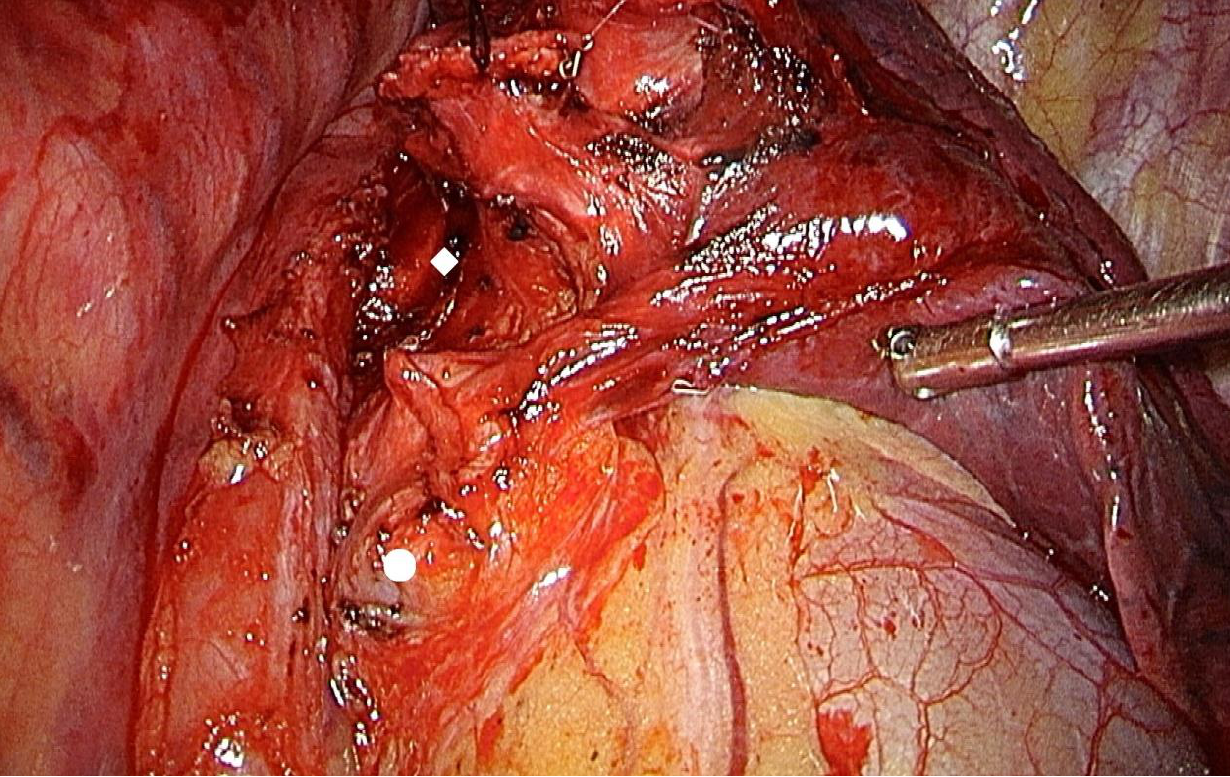
Figure 4. Lymph node station 7 and 8. Diamond: station 7; round: station 8.